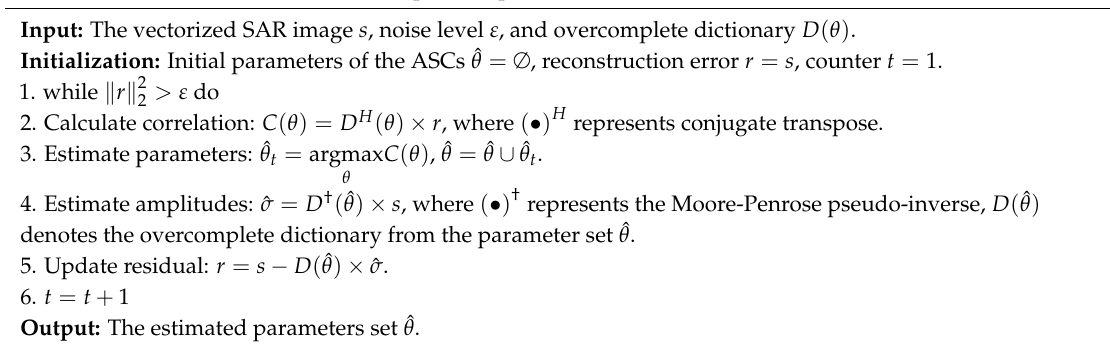
Algorithm 1 ASC Extraction based on Sparse